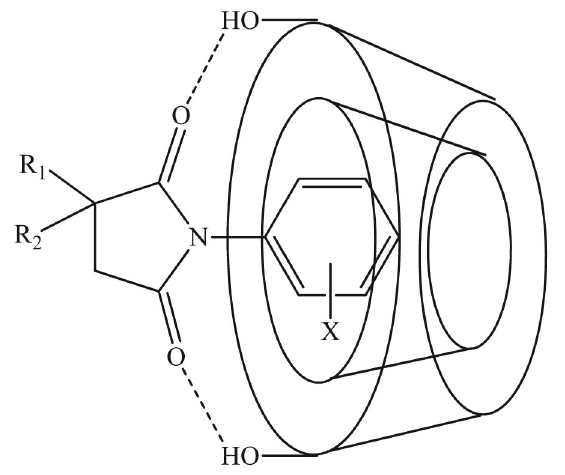
Figure 7 . Schematic illustration of the succinimide:cyclodextrin